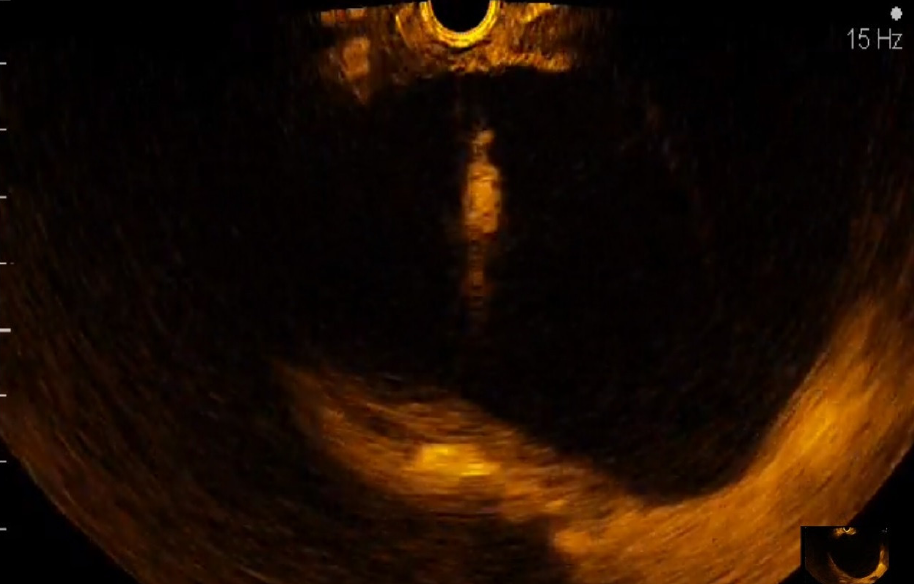
Figure 9. Contrast enhancement of a cystic mural nodule. Table 7. Percentage of EUS FNA/FNB needles used.